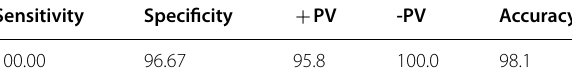
Diagnosis: benign prostatic hyperplasia (BPH). Figure 1. Diagnosis by biopsy: Adenocarcinoma Gleason scores 4 + 5 Figure 2.